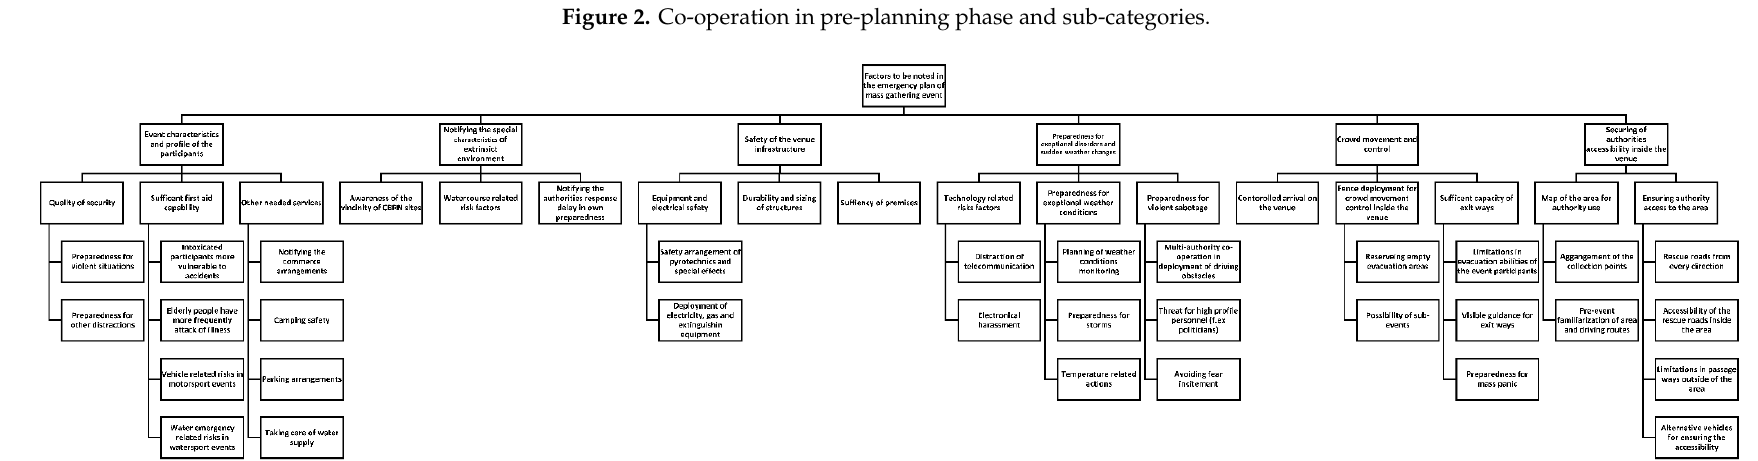
Figure 3. Factors to be noted in the emergency plan and sub-categories.